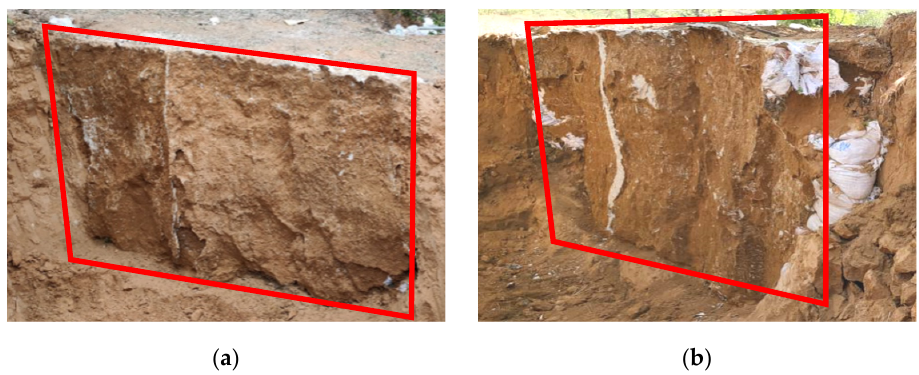
Figure 4. Excavation results of the ground fissure: ( a ) Excavation results in the western part of the ground fissure; ( b ) Excavation results in the eastern part of the ground fissure.